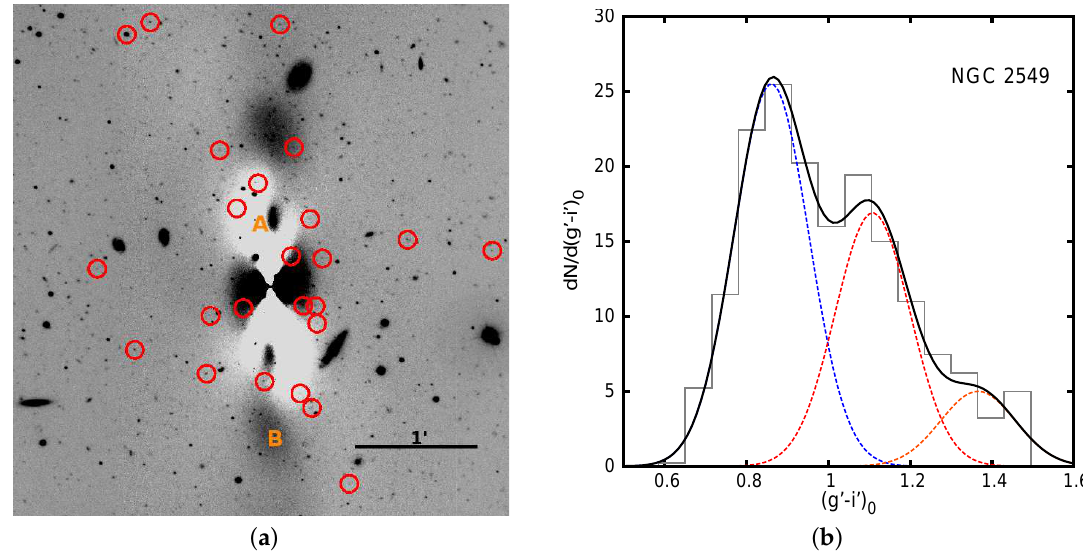
Figure 1. ( a ) Image after the galaxy light is removed. The letters A and B indicate the excesses of light possibly associated with two rings. Red circles show the position of the globular cluster (GC) candidates with reddest colours. ( b ) Colour histogram ( g (cid:48) − i (cid:48) ) 0 for the GC candidates of NGC 2549. The dashed lines show the Gaussian fit performed for each GC